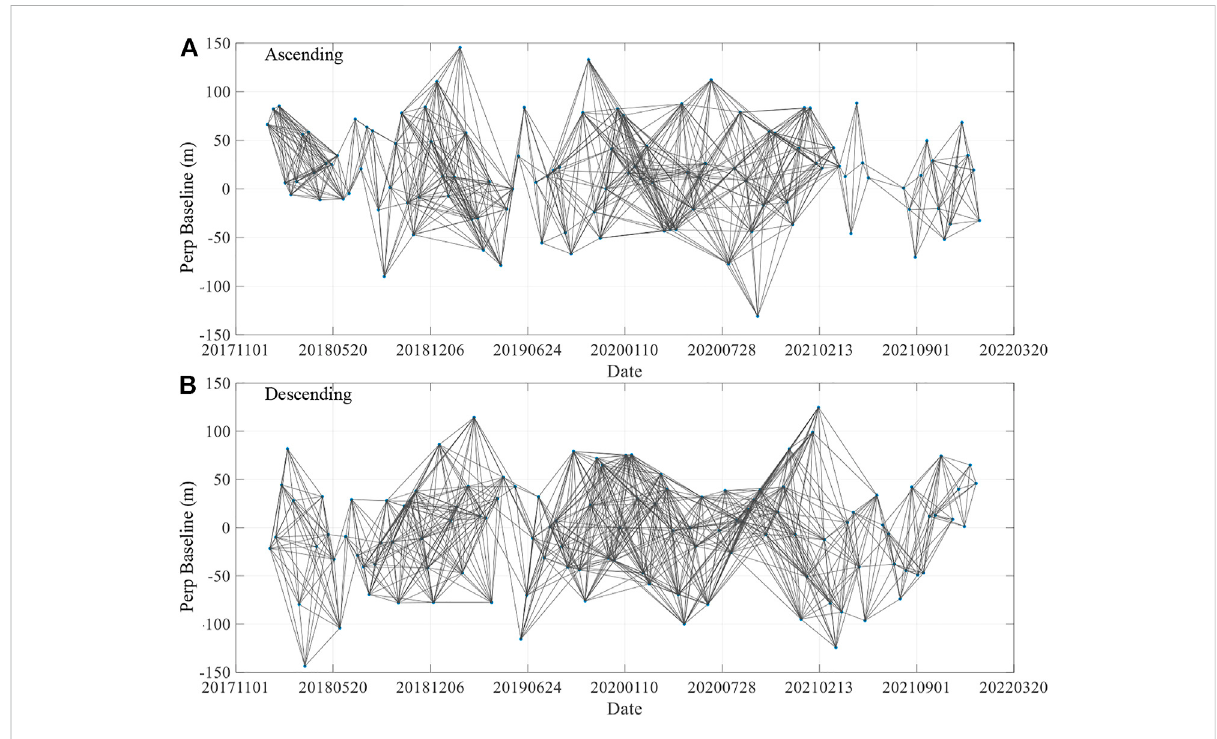
FIGURE 5 High-coherence interferogram rebuilding network after seasonal fi ltering. (A) and (B) indicate the network of ascending and descending